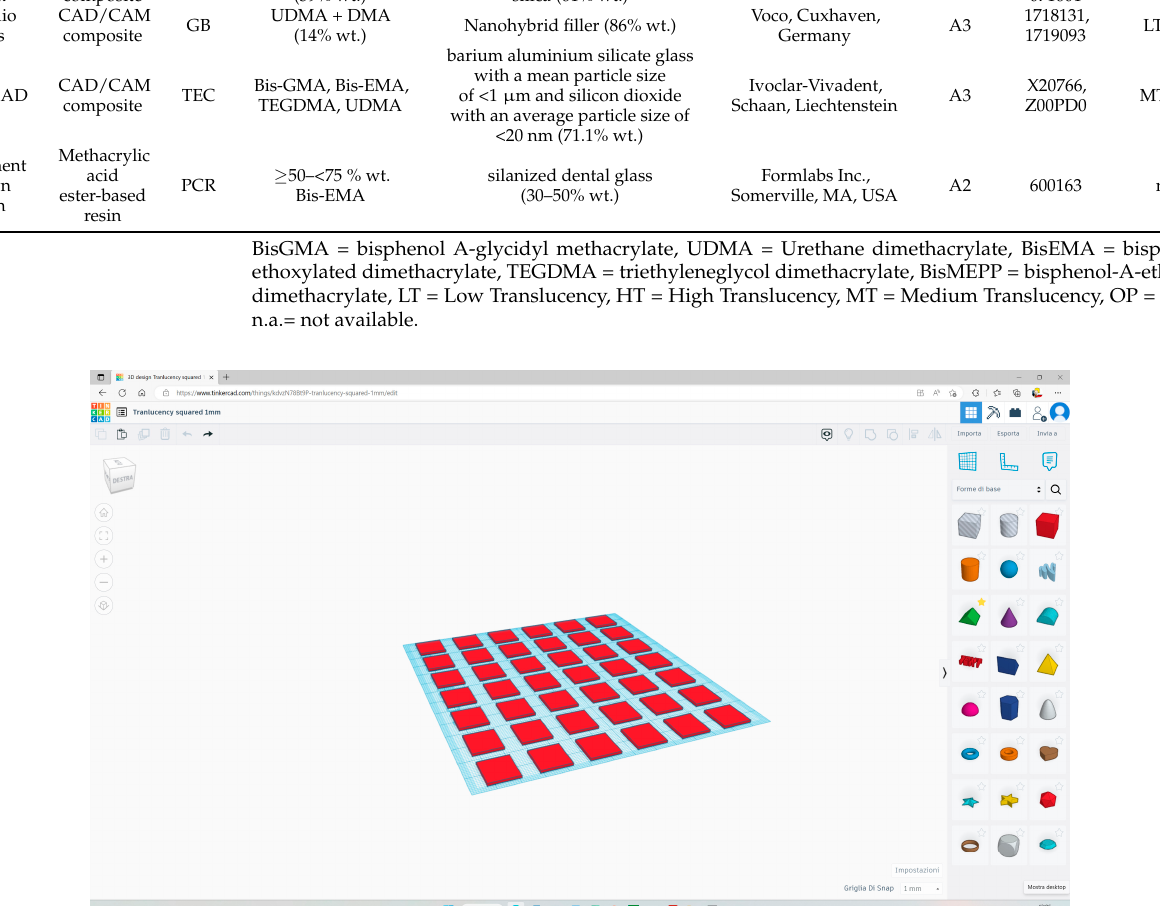
Figure 3. Specimens’ automatic supports calculation and slicing was performed in PreForm software. The printing parameters were set to 50-micron layer thickness using the exposure time provided by the software for the resin object of the test. Specimens were 3D printed with the Formlabs 3B 3D printer (Formlabs, Sommerville, MA, USA). After printing, specimens were removed from the printing platform, and still with raft and supports were subjected to the washing procedure for 3 min with the FormWash (Formlabs, Somerville, MA, USA), an automated washing machine, using 99% isopropyl alcohol (IPA), to remove uncured resin. After washing, the specimens were cured for 20 min at 60 °C in the FormCure (Formlabs, Somerville, MA, USA), an automatic curing machine from the same manufacturer. Then, the specimens were removed from supports, carefully sandblasted